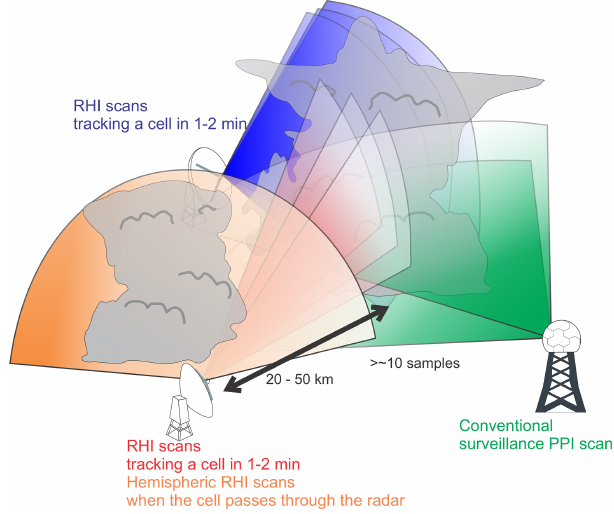
Figure 13. A schematic image of a suggested scan strategy opti- mized for observing convective cell evolution. Optimal cell track- ing is achieved by frequent RHI scans from more than one radar (blue and red scans) in addition to the operational PPI volume scans generally performed by the NEXRAD radars (green scans). The schematic also suggests an optimal hybrid radar scan strategy which switches between cell tracking by frequent RHI measurements and hemispheric RHI measurements depending on the distance between the radar and the target cell (red and orange